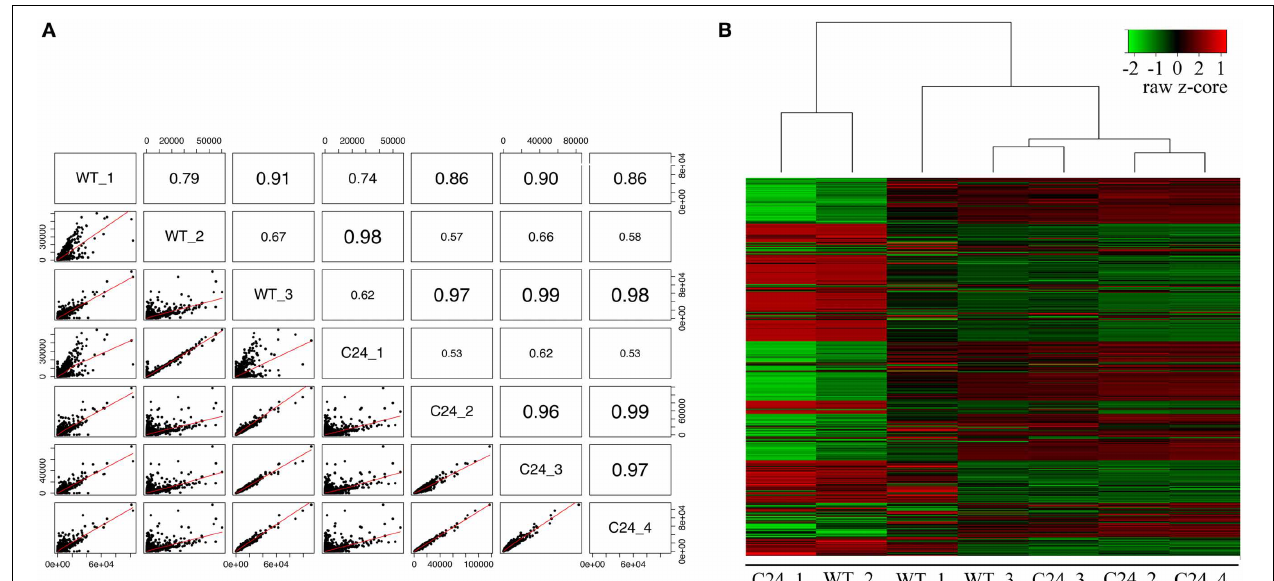
FIGURE 1 | Transcriptome profiling of Smn wt /elavGAL4 (WT) and Smn wt /elavGAL4-C24 (C24) Drosophila strains. (A) Correlation between samples estimated from normalized counts of gene expression of ∼ 12,000 genes in WT ( N = 3) and C24 ( N = 4) paired-end mRNA-seq libraries. Font size is varying according to the value of correlation. (B) Overview of hierarchical clustering of mRNA-seq datasets. Hierarchically clustered gene